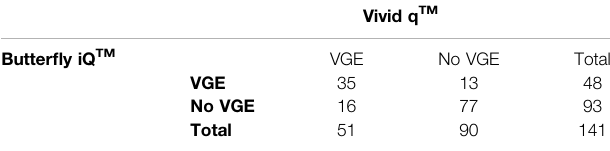
TABLE 4 | Contingency table showing venous gas emboli (VGE) presence agreement between the Butter fl y iQ TM and Vivid q TM . The Butter fl y iQ ™ sensitivity to VGE was found to be 68.6% and its speci fi city 85.6%.